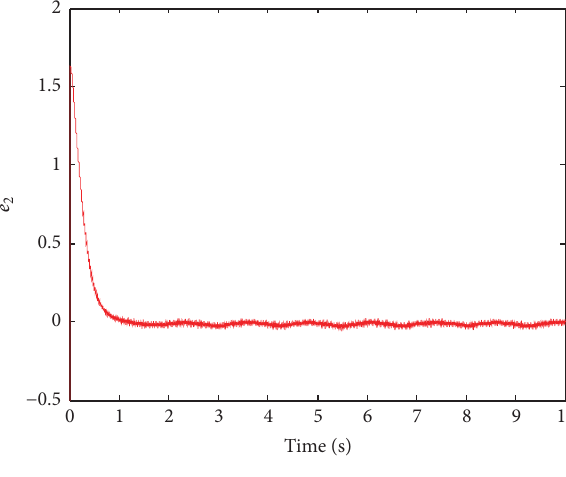
Figure 18: Tracking error 𝑒 2 of input signal 2.